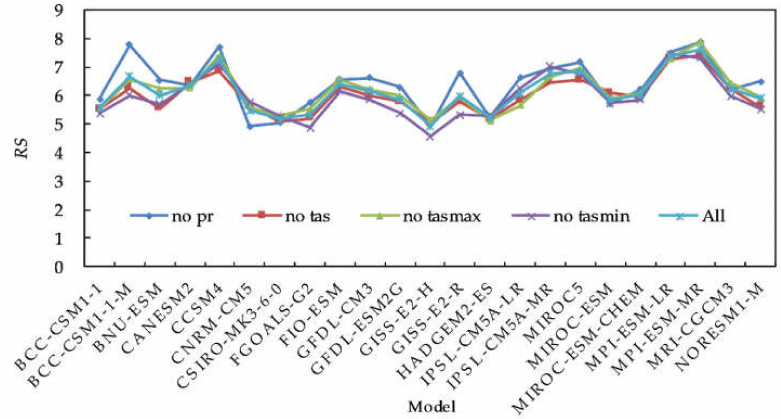
Figure 3. Sensitivity analysis for climate